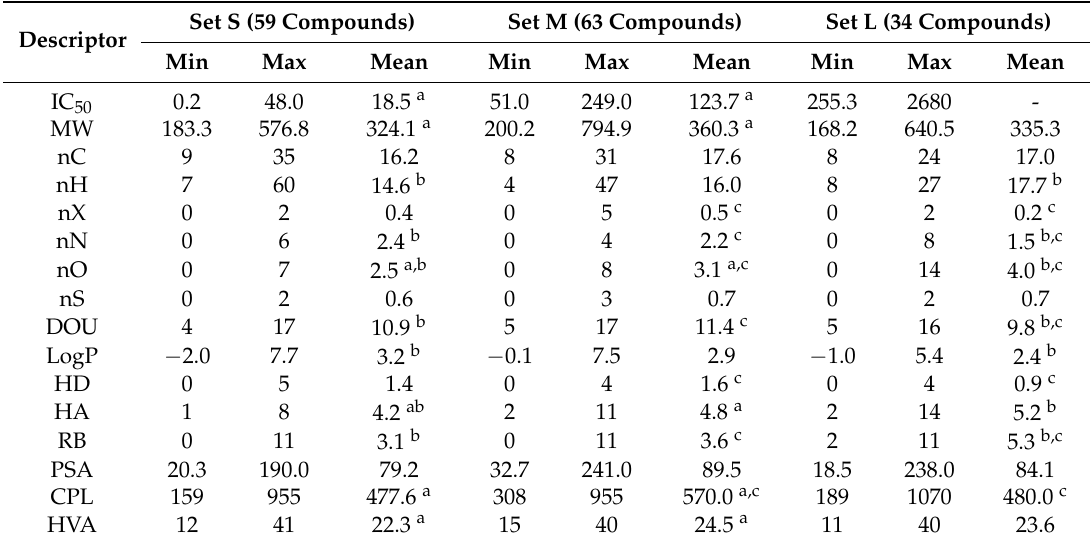
Table 1. Descriptive statistics for the structural descriptors of each SrtA inhibitors